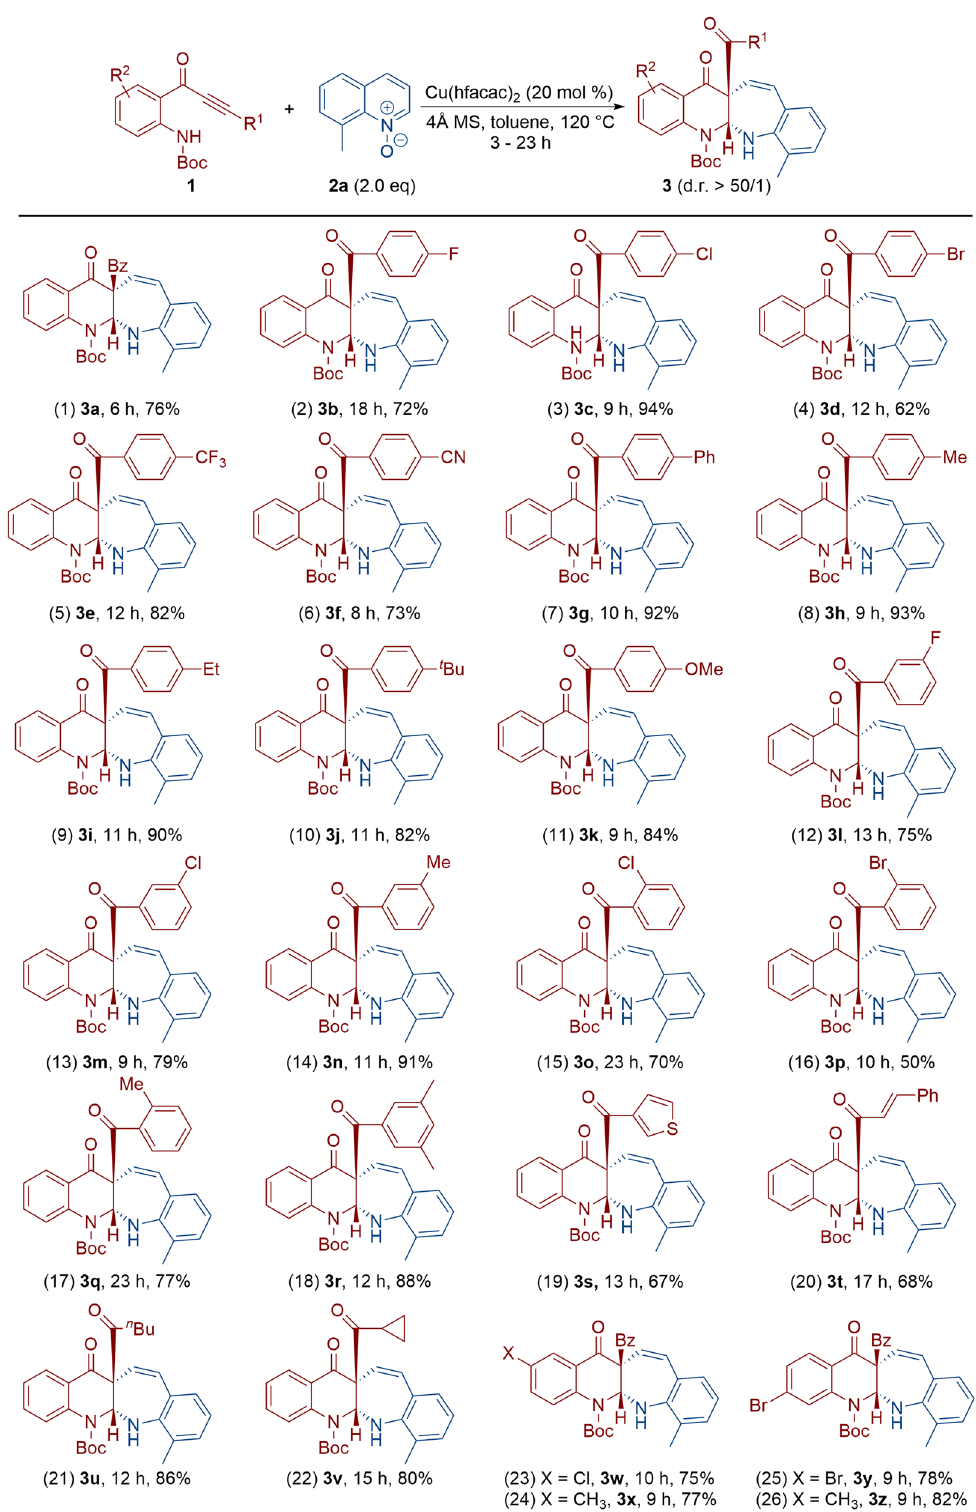
Fig. 2 Reaction scope with different alkynones 1. Reaction conditions: [ 1 ] = 0.05 M; yields are those for the isolated